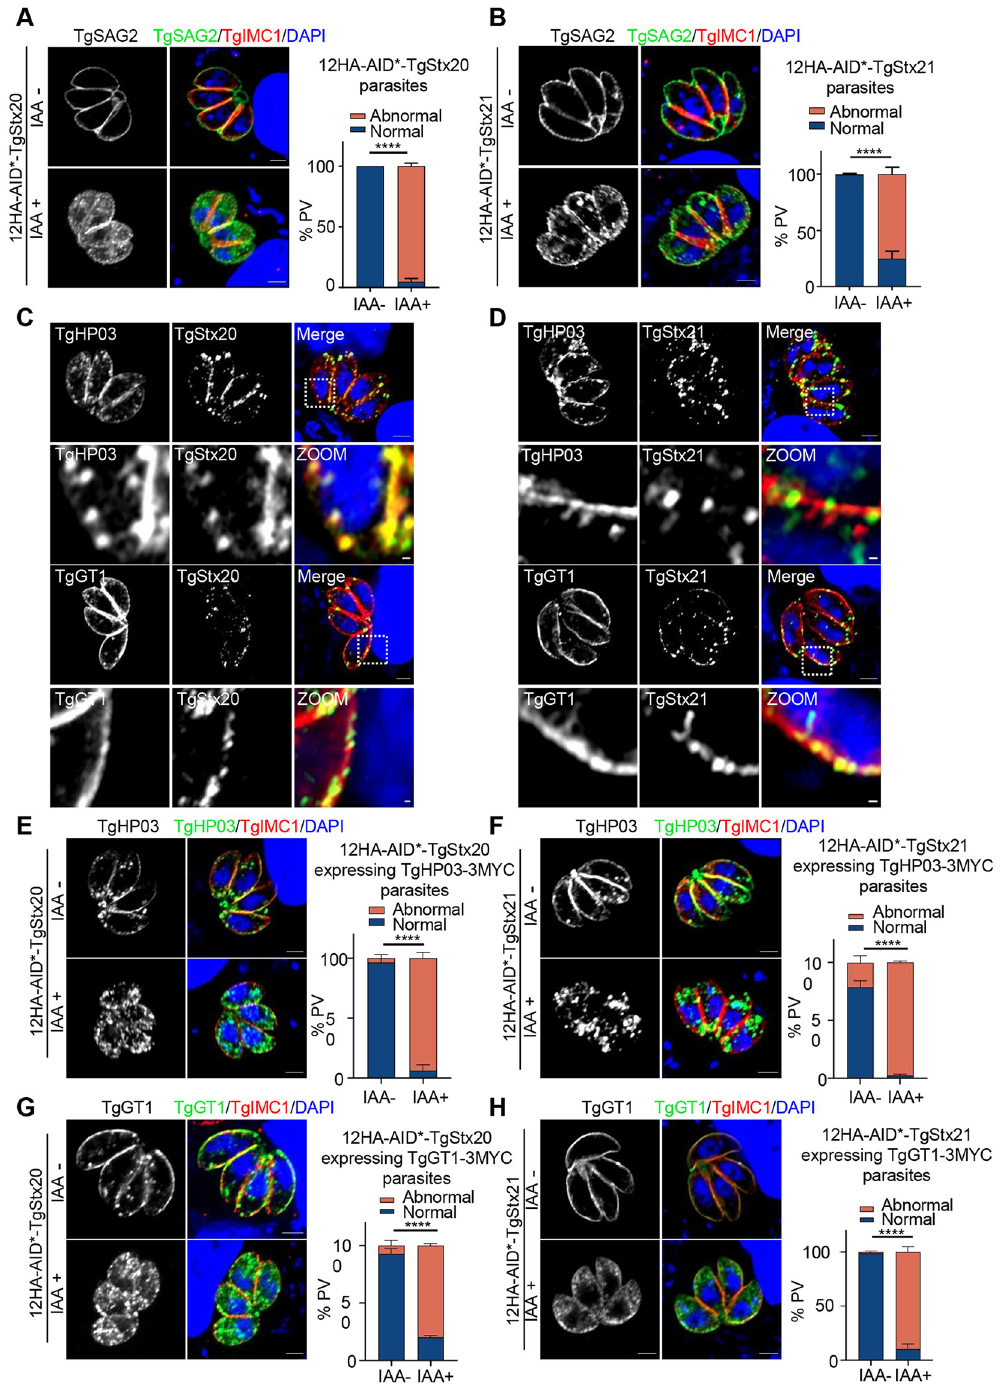
Fig 3. TgStx20 and TgStx21 are involved in the proper localization of transmembrane proteins to the PM. ( A ) and ( B ) IFA showing that conditional ablation of TgStx20 and TgStx21 affected the trafficking of TgSAG2 (green) to the plasma membrane. The parasite cortex was stained with a rabbit anti-TgIMC1 antibody (red). Scale bars: 2 μ m. Data are mean ± SEM from three independent slides, and at least 100 PVs were counted per slide. The difference in the number of abnormal PVs was statistically analyzed by a two-way ANOVA; **** P < 0.0001. ( C ) and ( D ) Co-localization of TgStx20 (green) and TgStx21 (green) with TgHP03 (red) and TgGT1 (red) using an IFA. 12HA-AID * -TgStx20 or 12HA-AID * - TgStx21 parasites were transfected with a plasmid expressing 3MYC-tagged TgHP03 or TgGT1, selected using pyrimethamine, and then analyzed by an IFA. Scale bars: 2 μ m (upper panels) and 0.2 μ m (zoomed panels). ( E ) and ( F ) IFA